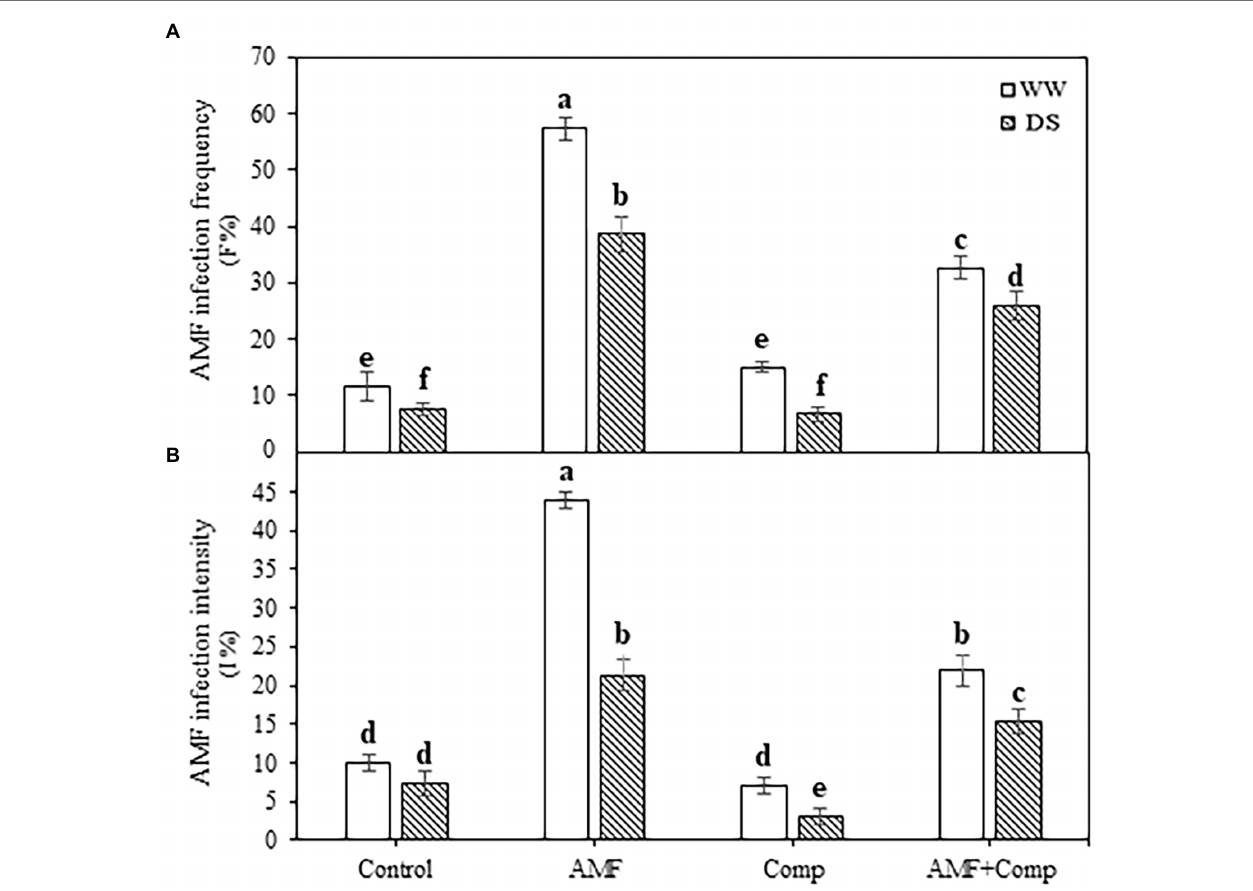
FIGURE 1 | Effects of water regimes (WW; well-watered or DS: drought stress) on AMF infection (A) frequency and (B) intensity of non-amended and non- inoculated quinoa (control) and quinoa inoculated with arbuscular mycorrhizal fungi (AMF) and/or amended with compost (Comp). Data are mean ± SD. Means followed by the same letters are not significantly different at p <